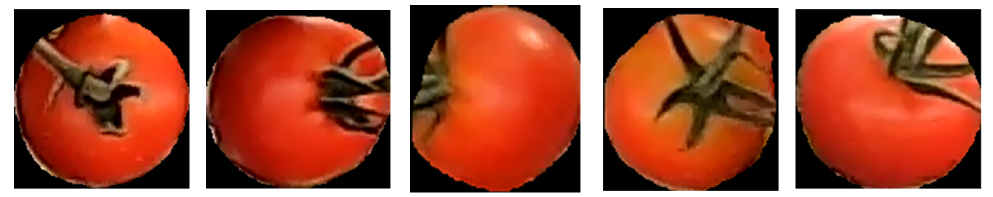
Figure 6. Examples of a harvested tomato.